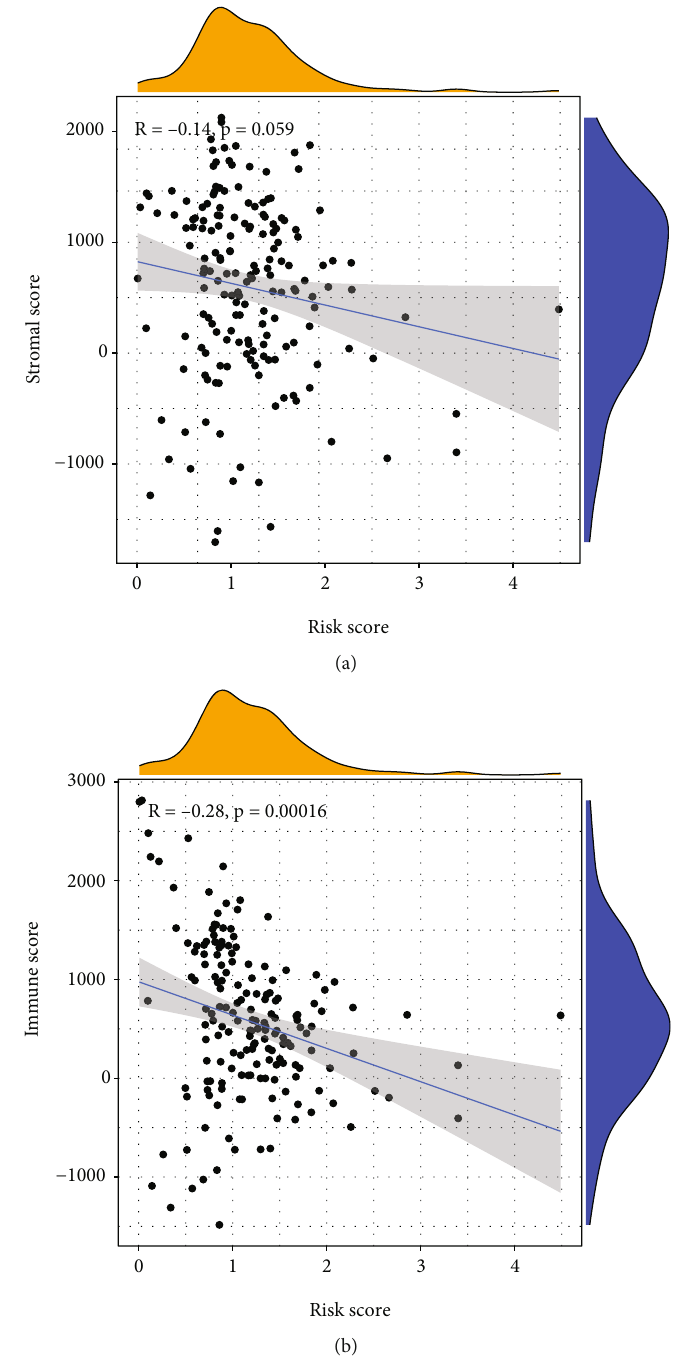
Figure 10: The relationships between risk score and (a) stromal score and (b) immune